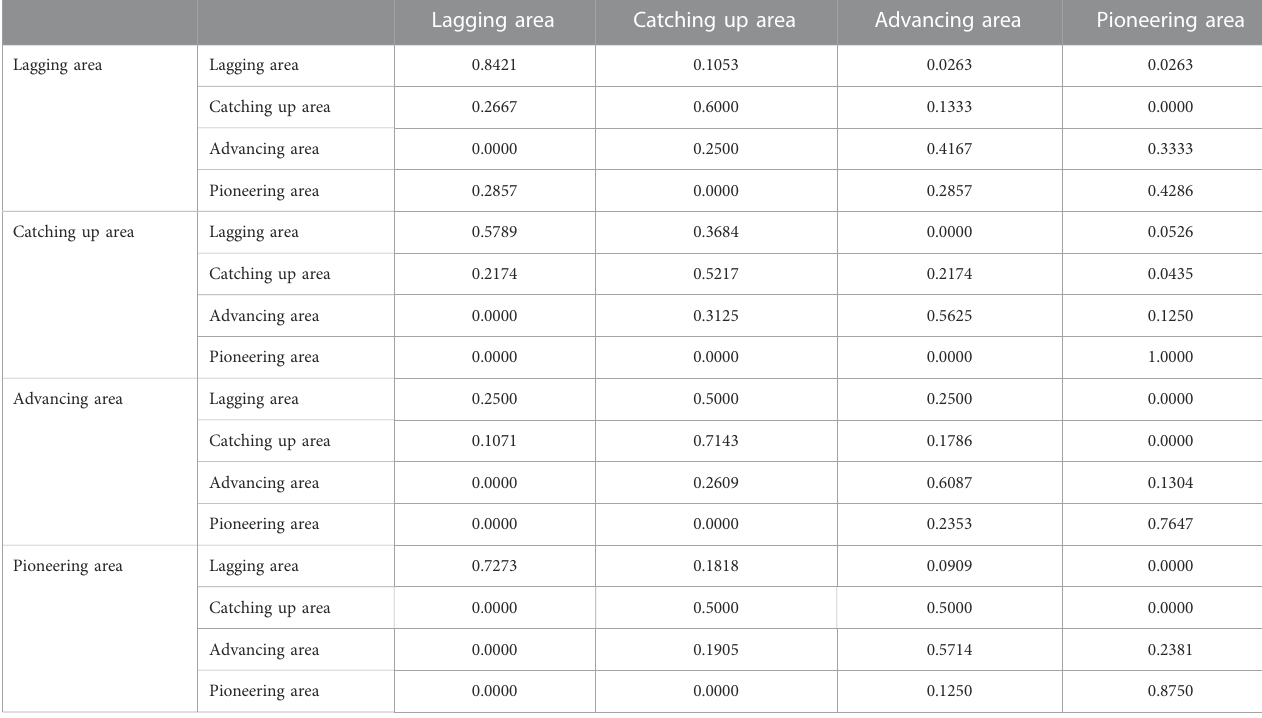
TABLE 3 The spatial Markov transition probability of the digital economy from 2011 to 2020.